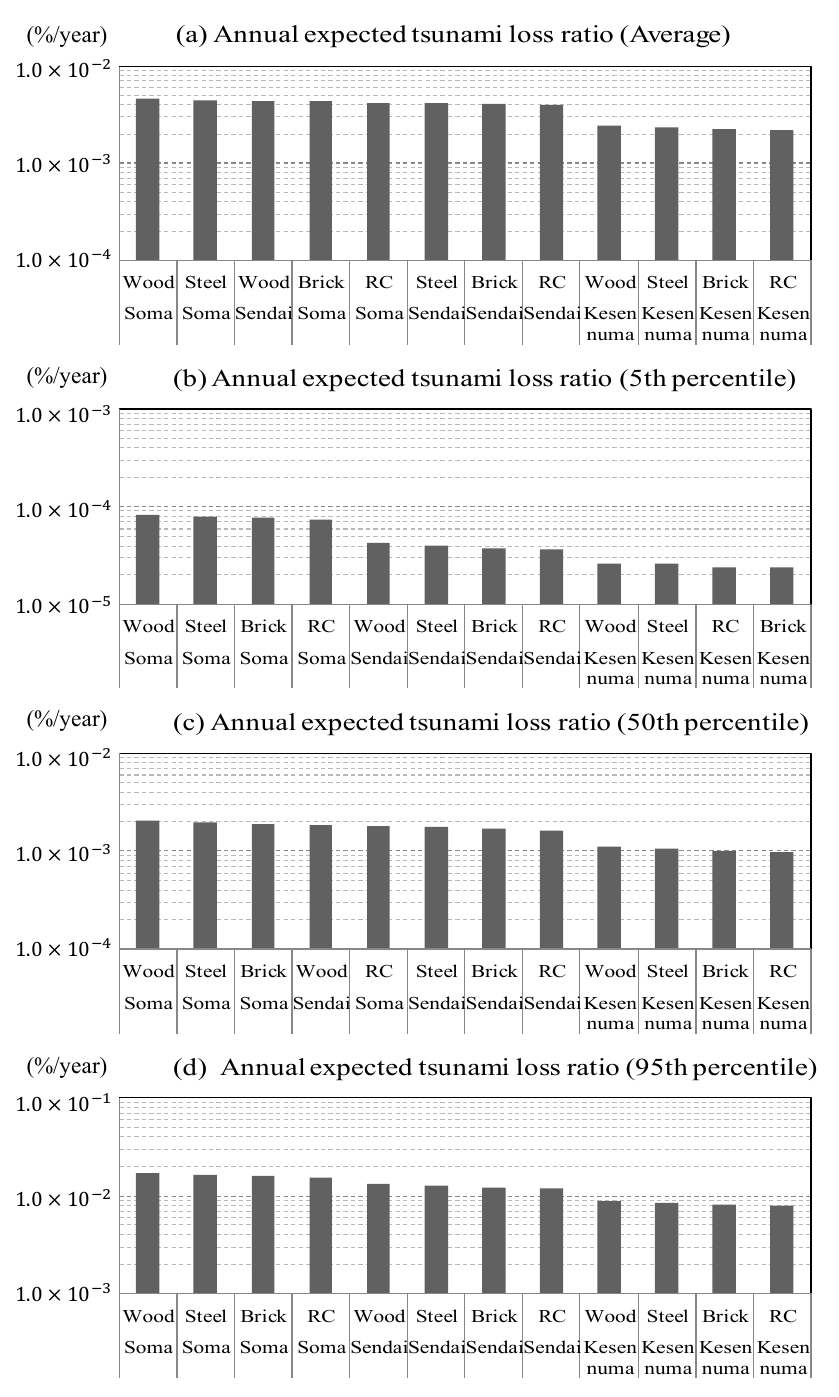
Figure 15. Expected value of the tsunami risk using each tsunami hazard value (( a ) average value; ( b ) 5th percentile value; ( c ) 50th percentile value and ( d ) 95th percentile value) indicated according to the structure (upper horizontal axis) and the region (lower horizontal axis).